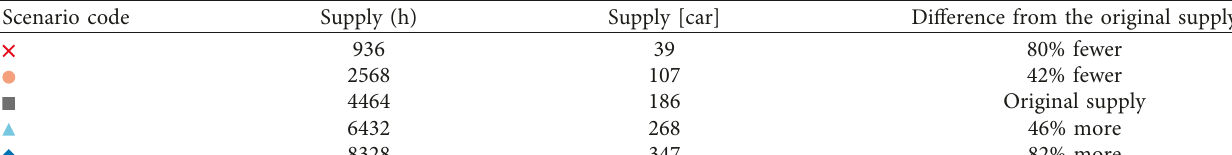
Table 5: Scenario definition for supply variation.